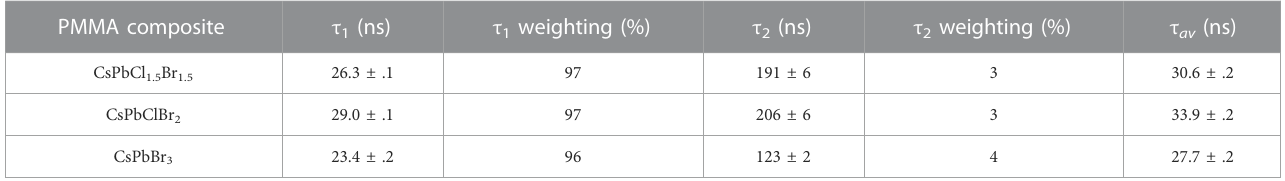
TABLE3Decaytimesandtheirrelative weightingsforthetimedecaycurvesofthe CsPbX 3 compositesinPMMA,illuminatedbyapulsed 100 kV2 kAX-rayand fi twith a biexponential curve. PMMA